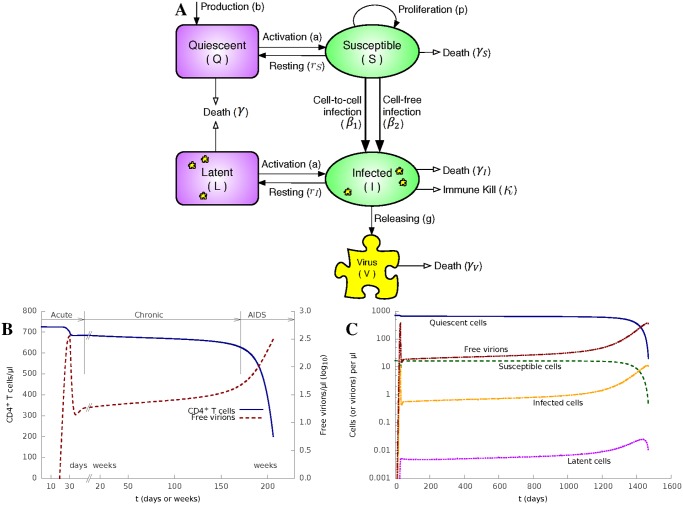
The HIV-1 model reproduces the full course of HIV-1 infection.
(A) Diagrammatic representation of the model described by Equation 1. (B) Numerical solutions of the model, plotting N, the density of all CD4+ T cells (y axis on the left) and V, the density of free virions (y axis on the right in log scale) as a function of time (in days or weeks), respectively. The initial infection starts on day 0 and the cellular immune response starts on day 30. Parameter values are in Table 1.(C) The density of quiescent, susceptible, latent and infected CD4+ T cells, and the density of free virions as function of time (in days).